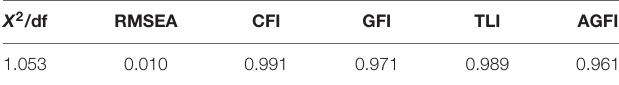
TABLE 5 | Reliability and validity of the measurement